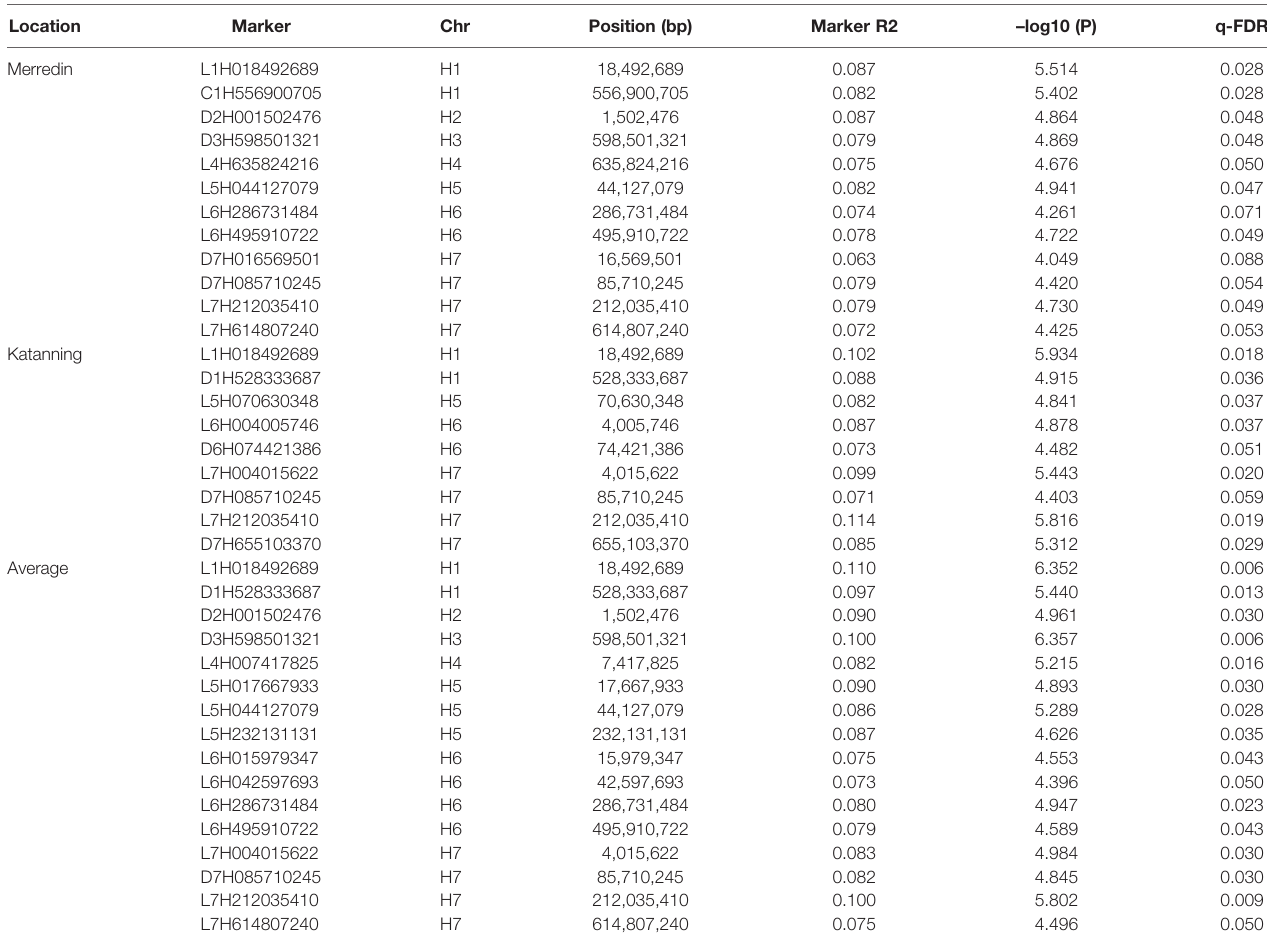
protein kinase family protein, MADS-box transcription factor family protein, protein kinase superfamily protein, RING/U-box superfamily protein, ubiquitin-like superfamily protein, and zinc fi nger protein family more than once at different chromosome locations indicated their involvement in enhancing salinity tolerance during germination ( Supplementary Table 5 ).